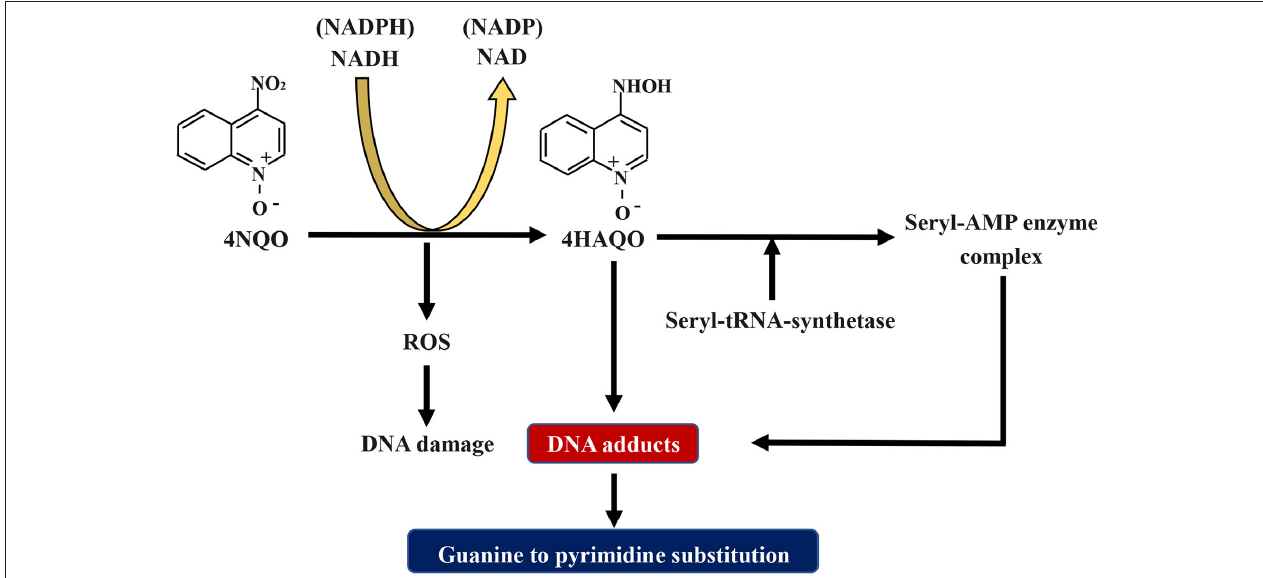
FIGURE 2 | Schematic diagram about the mechanism of 4NQO carcinogenesis. 4NQO is firstly reduced to 4HAQO by NADH and NAD(P)H, while 4HAQO can be acetylated by seryl-tRNA synthetase to form a seryl-AMP enzyme complex. The resultant 4HAQO and seryl-AMP enzyme complex are carcinogenic metabolites that induce the formation of DNA adducts. Mutations caused by these DNA adducts lead to guanine-to-pyrimidine substitution. Adhesions: 4NQO, 4-nitroquinoline-1-oxide; 4HAQO, 4-hydroxy amino